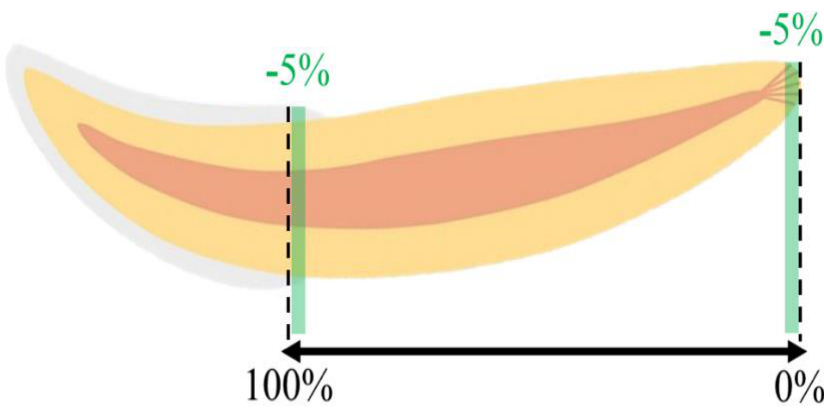
Figure 2. Schematic representation of the studied region of the tooth.